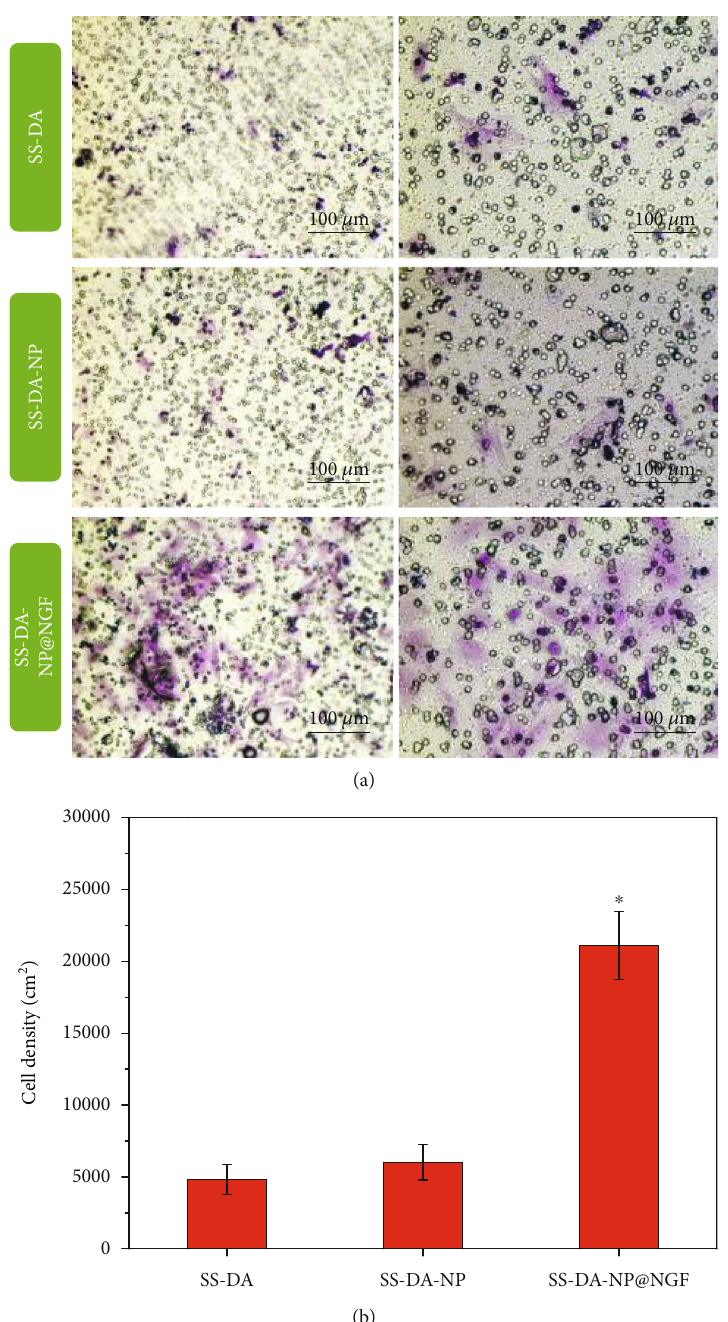
Figure 6: Mobilization and homing behavior of EPCs induced by nanocoating. (a) Crystal violet staining image of EPCs that mobilized to the bottom of the transwell chamber, and (b) cell counting result ( mean ± SD , n = 6 , ∗ p < 0 : 05 indicates signi fi cant di ff erence compared to SS-DA and